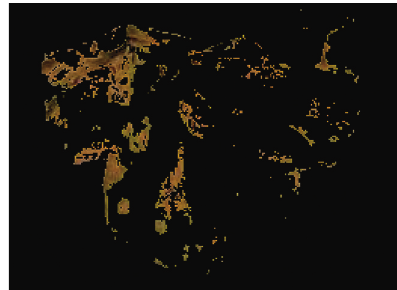
Figure 8: Image labeled by cluster index.